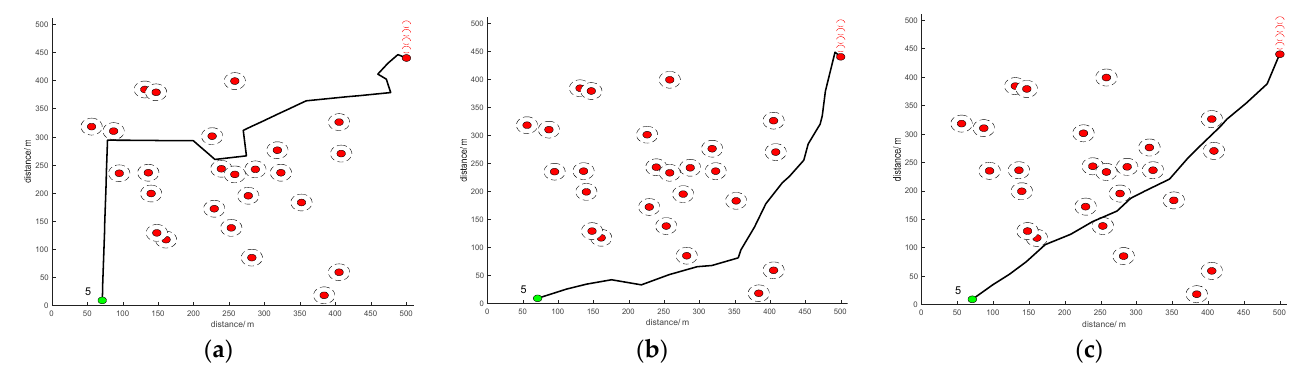
Figure 11. The path results of each algorithm for vehicle No. 5 with 30 vehicles in MUVs. ( a ) is the path result of RRT-connect; ( b ) is the path result of RRT*; ( c ) is the path result of dual RRT optimization.